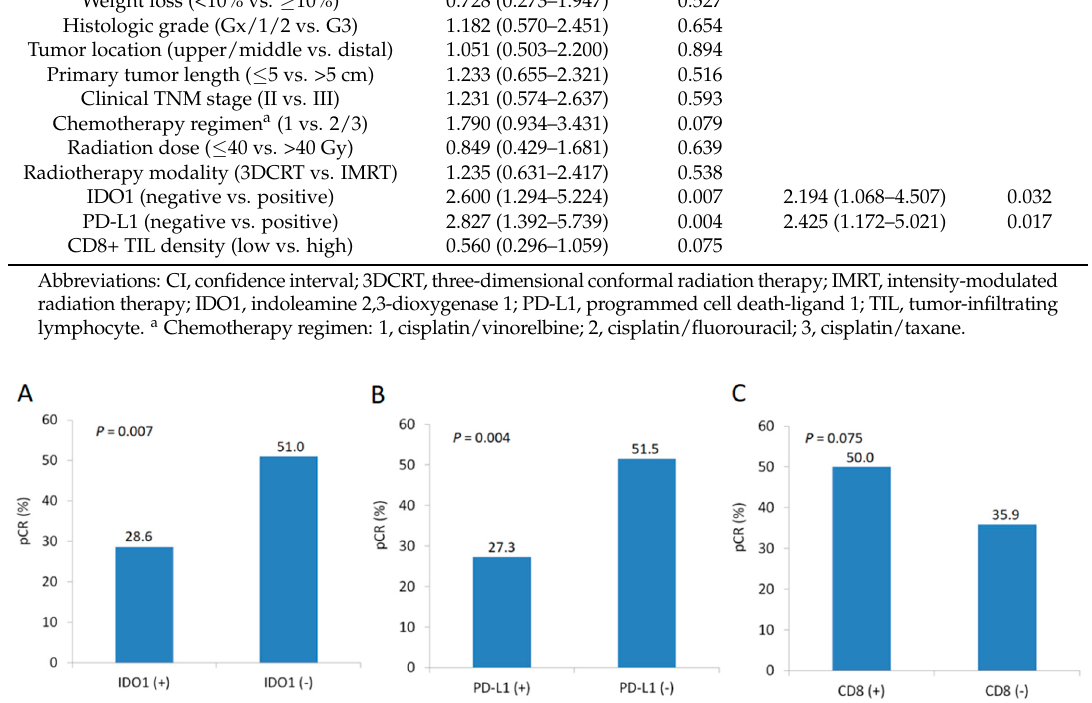
Table 3. Univariate and multivariate analyses for variables associated with pathologic complete response.